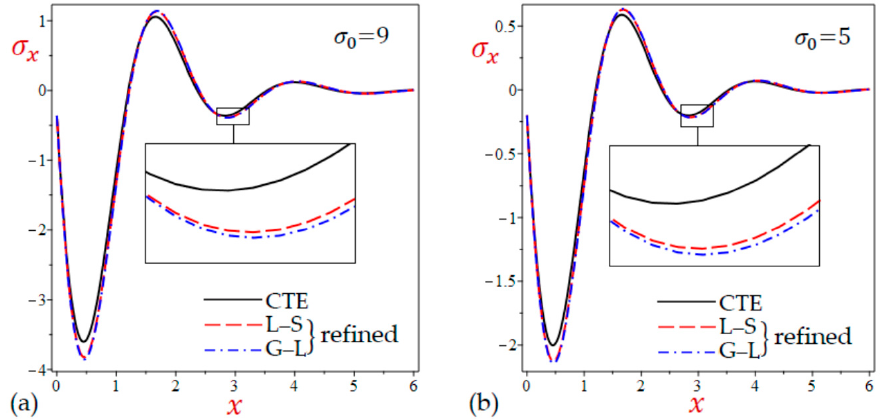
out initial pressure ( 𝓅 = 0 ) ( a ) 𝜎 (cid:2868) = 9 ; ( b ) 𝜎 (cid:2868) = 5 .